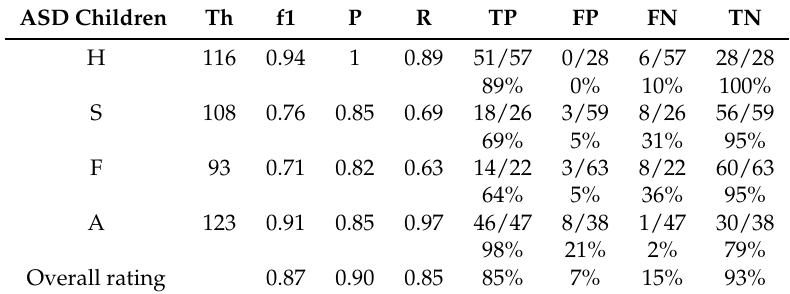
Table 9. Accuracy of the automatic system with respect to manual annotations for ASD children when the best decision threshold (in terms of F1-score) for each expression was used.